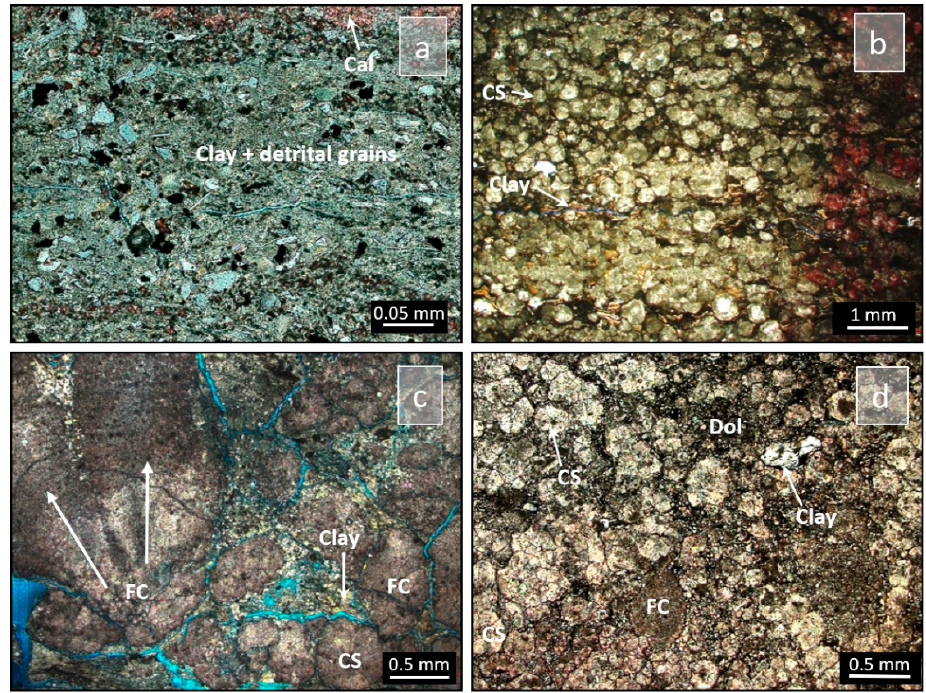
Figure 2. Microfacies. ( a ) Laminated carbonate – MF-1. ( b ) Carbonate spherulites (CS) and clays – MF-2. ( c ) Fascicular (shrub-like) carbonate (FC) – MF-3. ( d ) Intraclastic carbonate – MF-4.